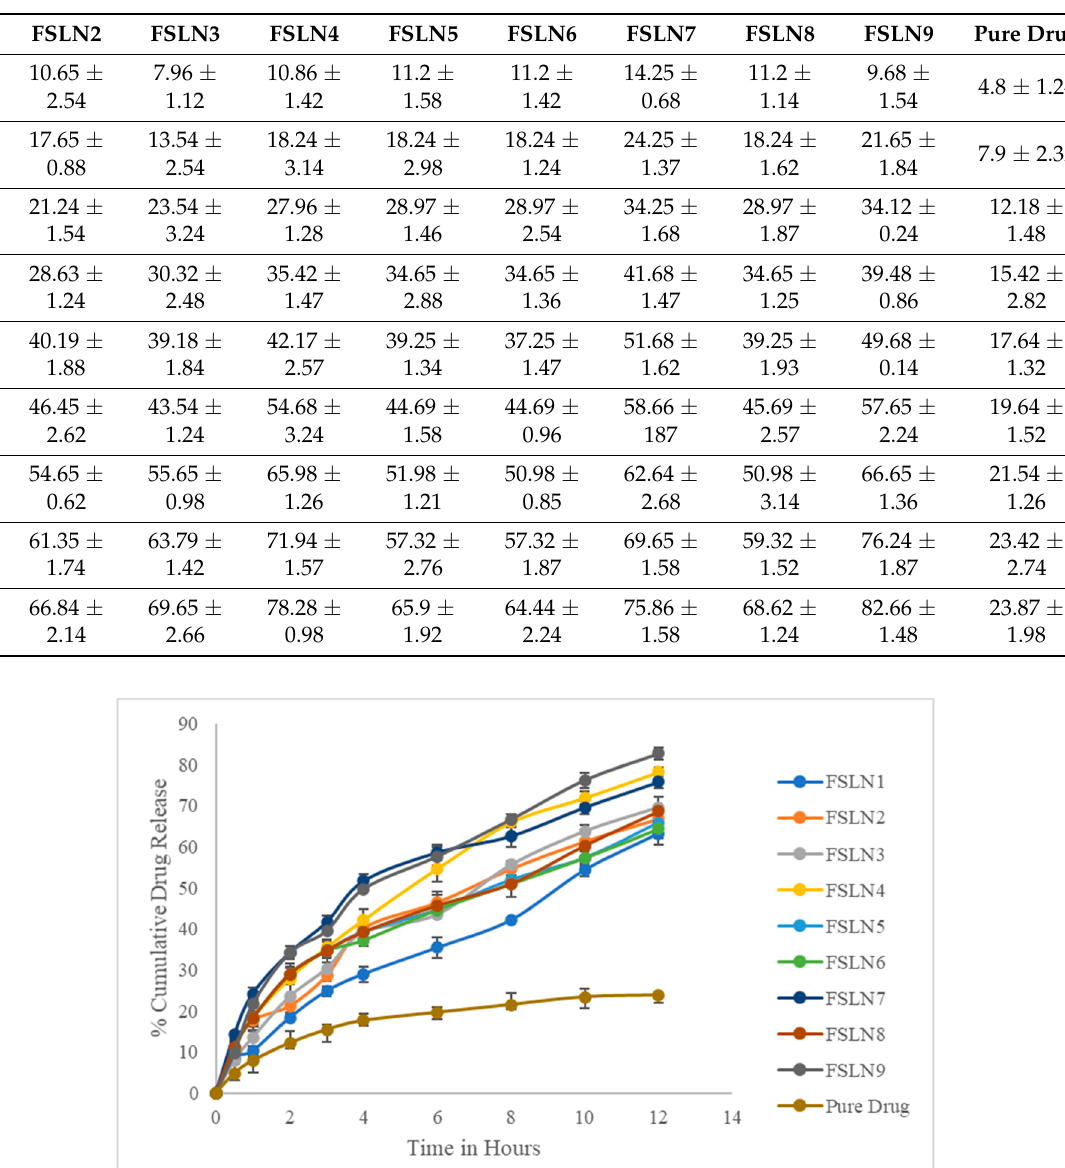
Table 3. In-vitro drug release data of all formulations (Data represents mean of six determinations ± standard deviation).